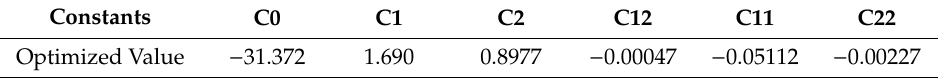
Figure 15. Response-surface method (RSM) analysis (inputs: Flow rate and temperature). Table 4. The optimal values of the constants which are obtained by RSM optimization.